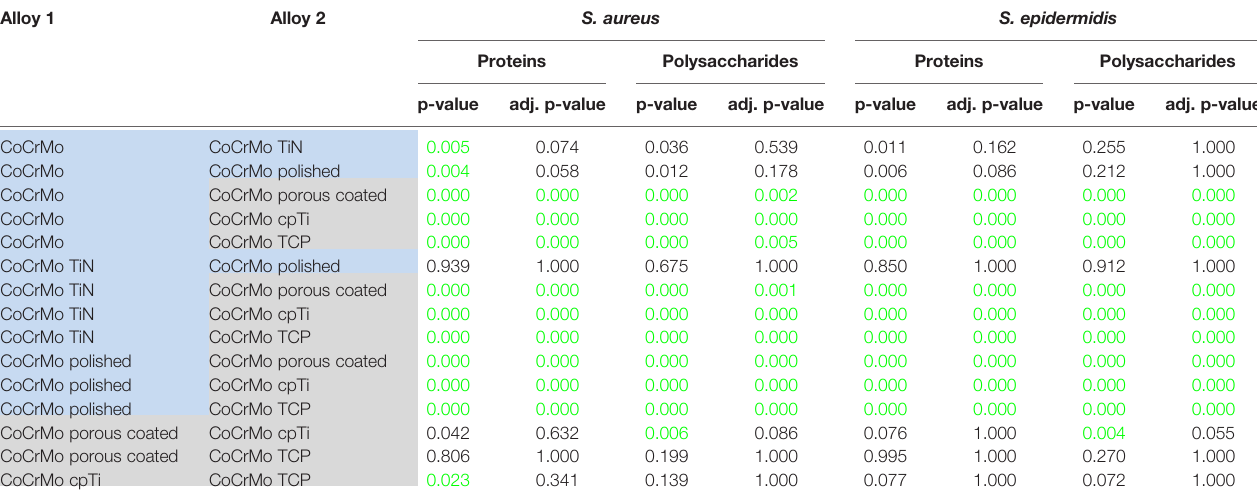
TABLE 3 | Statistical pairwise comparison of alloys according to the protein and polysaccharide content of the S. aureus and S. epidermidis bio fi lms. Alloy 1 Alloy